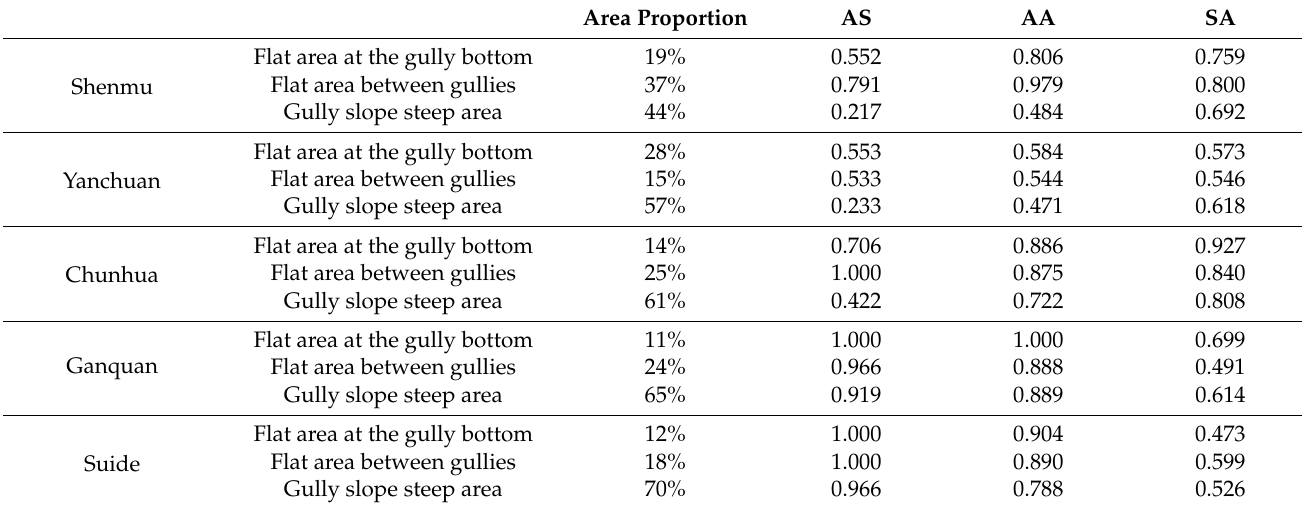
Table 3. The partition fusion weight table of various areas. Area Proportion AS AA